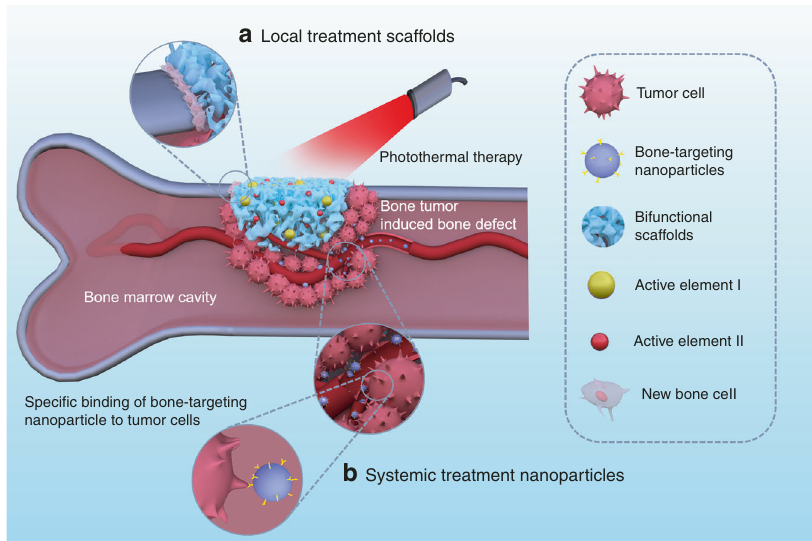
Fig. 1 Bifunctional biomaterials include ( a ) local treatment scaffolds (such as 3D-printed scaffolds, nano/microparticle-containing scaffolds, and hydrogels) and ( b ) systemic treatment nanoparticles (such as bone-targeting nanoparticles) for tumor photothermal therapy and bone